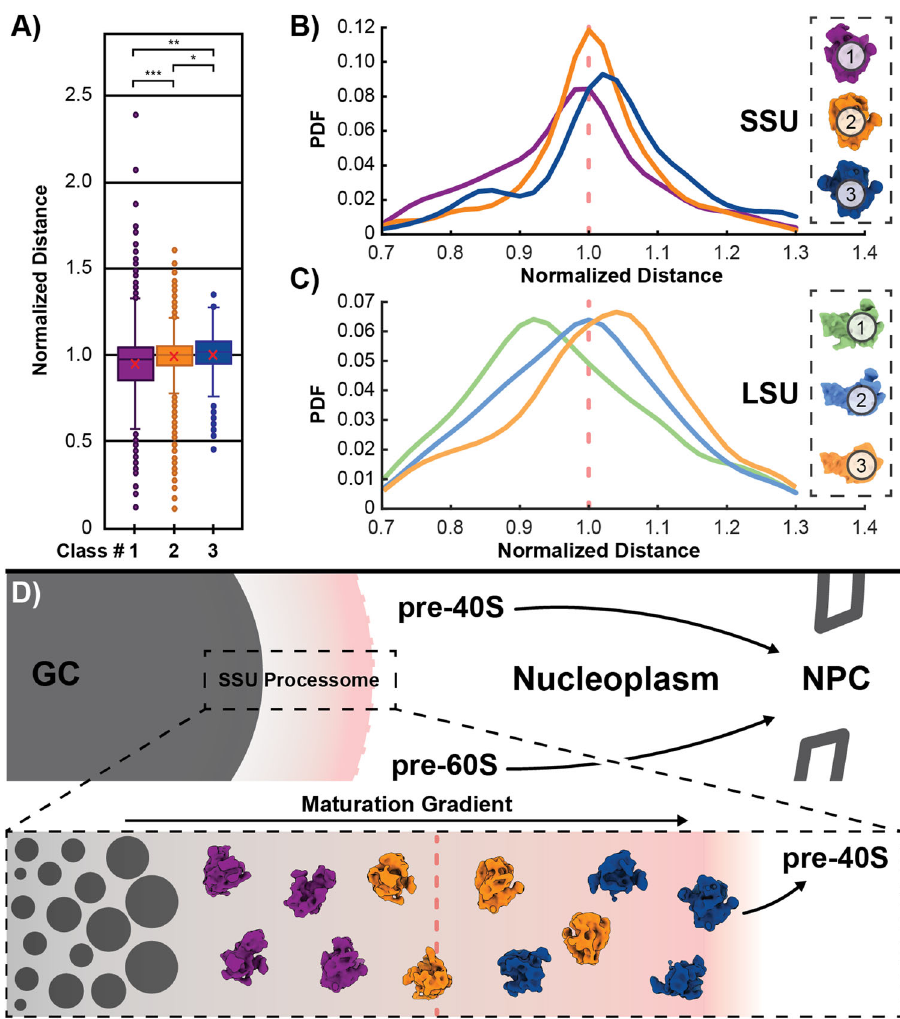
Fig. 4 Sub-Nucleolar Partitioning of Pre-Ribosomes. A The SSU processome classes show signi fi cant differences in their spatial distribution depending on their level of maturation ( n = 26 tomograms; two-sided Fisher-Pitman permutation test 60 of mean: p 1,2 = 1 E − 6, p 1,3 = 1.07 E − 04, p 2,3 = 4.1 E − 02; n = 1809 particles; data are represented as boxplots where the red cross indicates the mean, the middle line is the median, the lower and upper hinges correspond to the fi rst and third quartiles, top and bottom whiskers indicate maximum and minimum, respectively. Circles show outlier points. See Supplementary Fig. 7d for pre-60S results. B , C Plotting the probability density function (PDF) for the large and small subunit precursors reveals discrete behaviors. There is a sharp peak for SSU Class 2 & 3 at the nucleolar surface and Class 1 displays higher probabilities at smaller radii. Likewise, pre-60S Class 1 shows a peak at even lower distances, implying that particles can still be detected further inside the nucleolus and that template matching is not restricted to its periphery ( n = 26 tomograms). D The data suggests a model, in which pre-ribosomal particles are separated in maturation gradients and thus provide molecular order to the nucleolus and ribosome biogenesis. SSU Small subunit, LSU large subunit, GC Granular Component, NPC Nuclear Pore Complex. Source data are provided as a Source Data fi cooled by an open nitrogen circuit. Lamellas were cut from randomly selected, mostly individual C. reinhardtii cells analogous to published protocols 44 . Cryo-TEM . Cryo-tomograms were acquired on a transmission electron microscope (Titan Krios, FEG 300 kV, FEI) with a post-column energy- fi lter (968 Quantum K2, Gatan) with a defocus range of − 5µm to − 3.5 µm and an EFTEM magni fi - cation of 42000x (calibrated pixel size 3.42 Å). Images were recorded with a direct detection camera (K2 Summit, Gatan) in dose-fractionation mode and a total dose of ~120e – / Å 2 per tomogram using SerialEM 45 . The acquisition was controlled by an in-house script running a dose-symmetric tilt scheme 46 with an angle increment of 2° between the range of 70° and − 50° starting at 10° to compensate for the lamella pre-tilt (~12°). In addition to the dose symmetric tilt schemes, 21 out of the total 85 tomograms were recorded using a bi-directional scheme with an angular increment of 2° starting at – 20° and going to + 70°. This was followed by a second branch from – 22° to – 50° to complete the series. Frames were aligned using motioncorr2 47 , the contrast transfer function (CTF) estimated using CTFFIND4 48 , stacks were assembled using an in house Matlab (MathWorks) script, and tilt-series LSU precursor were separated and re fi ned individually, yielding the SSU and LSU alignment as well as tomogram reconstruction was performed in IMOD 49 using precursor global averages depicted in Supplementary Fig. 2.